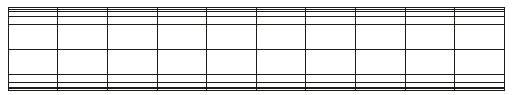
Figure 2: Initial mesh for reactor flow problem.